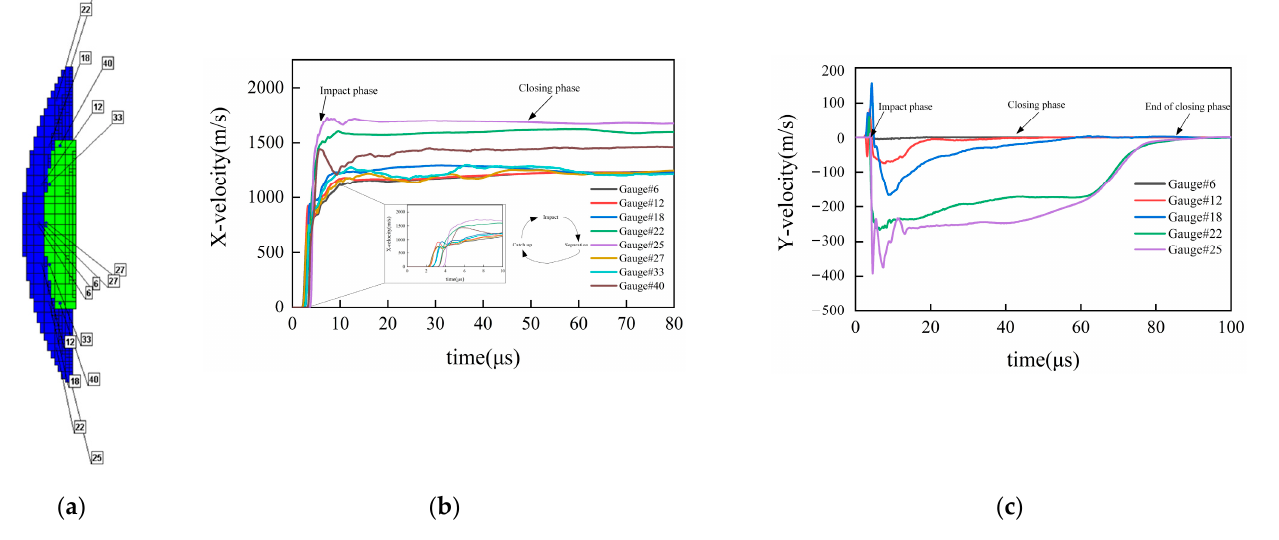
Figure 5. Axial and radial velocity curve of typical observation points: ( a ) Distribution and number of gauge points setting; ( b ) Axial velocity curve of typical observation points; ( c ) Radial velocity curve of typical observation points.